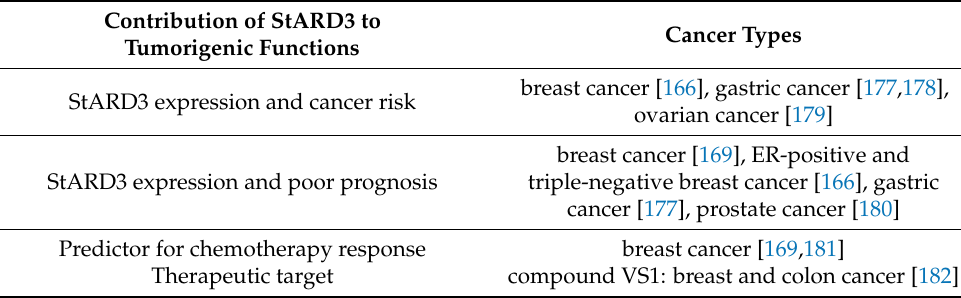
Table 3. Characteristics and roles of StARD3 in